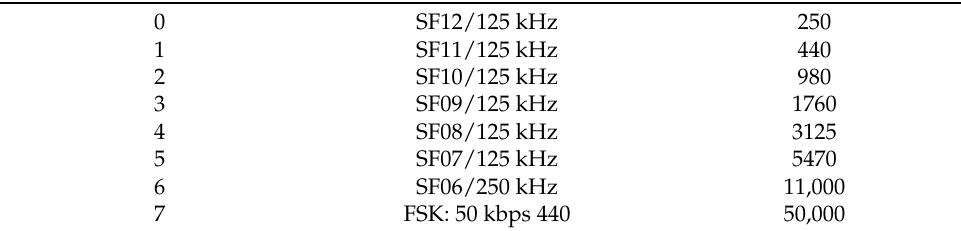
Table 1. LoRa/LoRaWAN main characteristics based on the EU 863–870 MHz data rates.